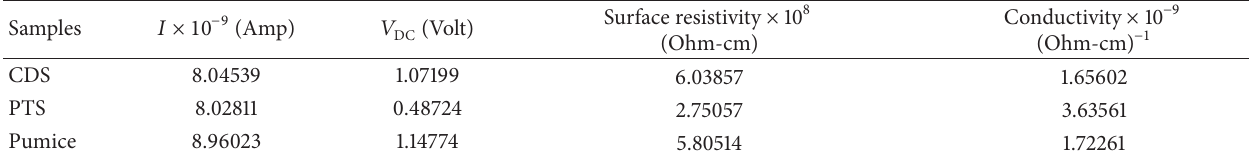
Table 1: The surface resistance